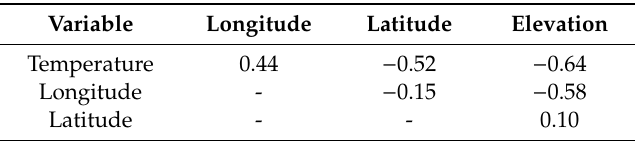
Table 1. Pearson correlation coe ffi cients for relationships between summer water temperatures at 1-m in depth in United States lakes and lake latitudes, longitudes and elevations. All relationships were statistically significant ( p <